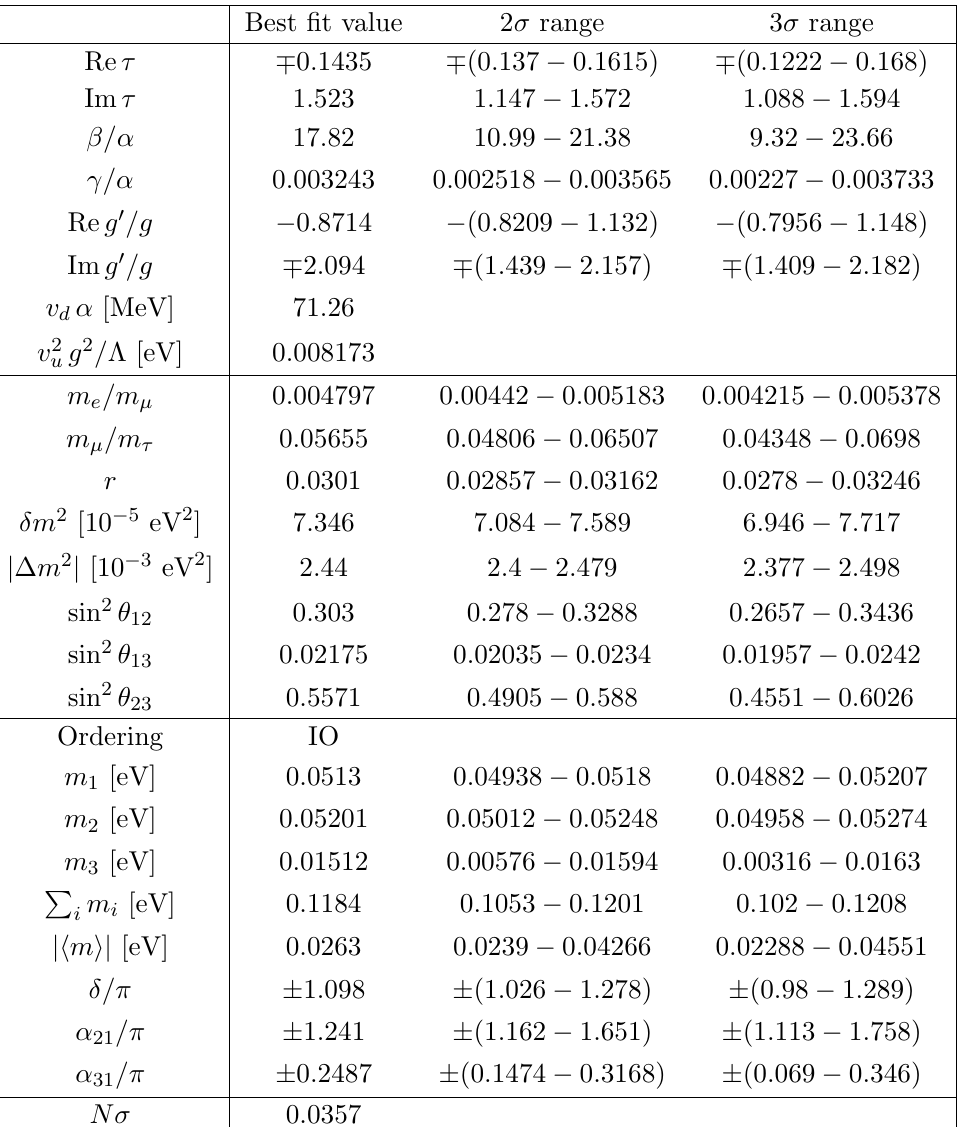
Table 5c. Best (cid:12)t values along with 2 (cid:27) and 3 (cid:27) ranges of the parameters and observables in cases C and C (cid:3) , which refer to ( k (cid:3) ; k g ) = (0 ; 2) and to a certain region in the (cid:28) plane (see (cid:12)gure